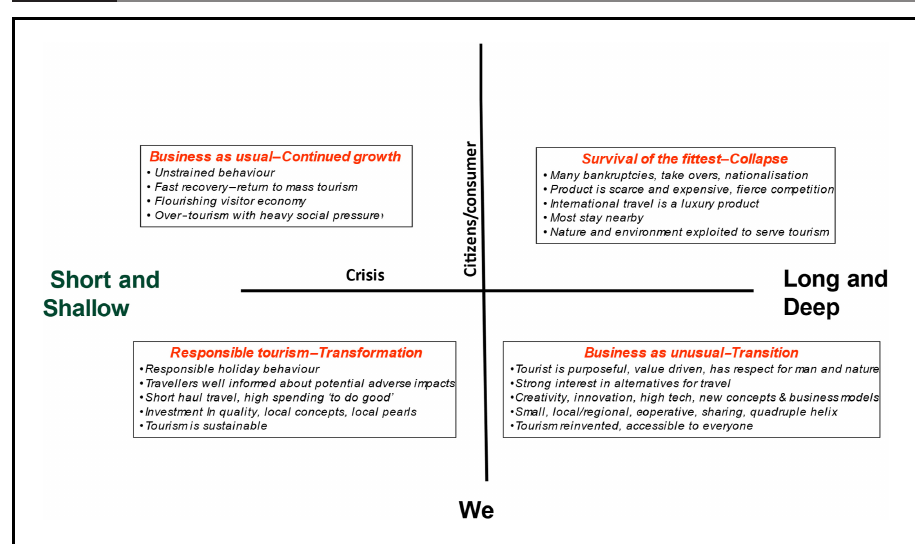
Figure 1 Four post-COVID-19 scenarios for global tourism in